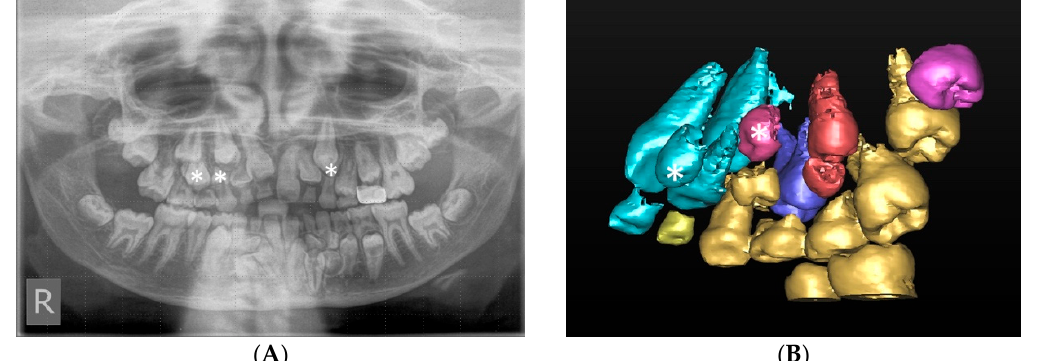
Figure 3. ( A ) Panoramic radiograph demonstrating multiple supernumerary teeth in the maxilla and mandible. There are three clearly visible supernumerary teeth in the maxilla (marked with asterisks. ( B ) Three-dimensional (3D) segmented reconstruction of the right maxilla viewed from the palatal aspect showing two further maxillary supernumerary teeth marked with an asterisk, one palatal to the upper right central incisor and the other palatal to the upper right canine (©DentsplySirona-Simplant® Pro).